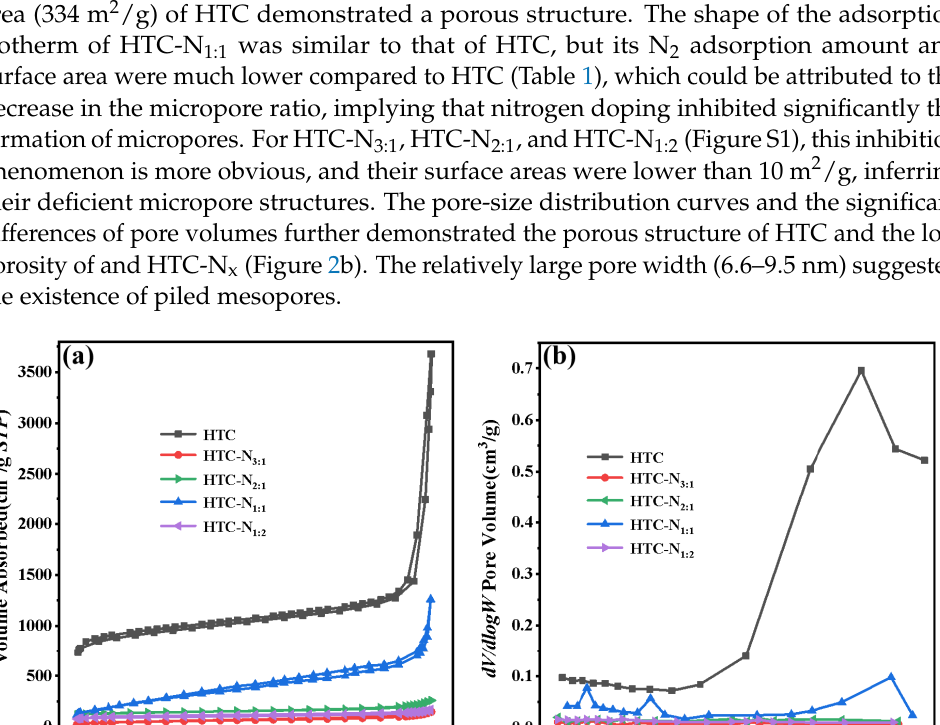
Figure 2. N 2 absorption – desorption isotherms ( a ) and pore-size distribution curves of the carbon supports ( b ). Table 1. Textural and structural properties of the carbon supports. Sample